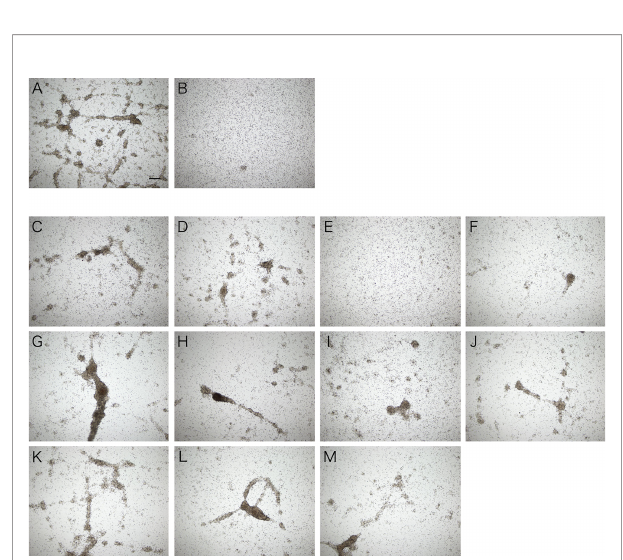
FIGURE 7 | Inhibitory effect of galactose on cellular aggregation. Microscopic observation. Coelomic fl uid was supplemented with (A) the intestinal extract, (B) PBS, or (C – M) the intestinal extract premixed with 0.1 M sugar solution (in PBS). (C) D (+)-glucose. (D) D (+)-mannose. (E) D (+)-galactose. (F) D (+)-xylose. (G) L ( − )-fucose. (H) L (+)-rhamnose. (I) N- acetyl-D-glucosamine. (J) N- acetyl-D-galactosamine. (K) D (+)-maltose. (L) D (+)-lactose. (M) D (+)-sucrose. Scale bars = 200 m